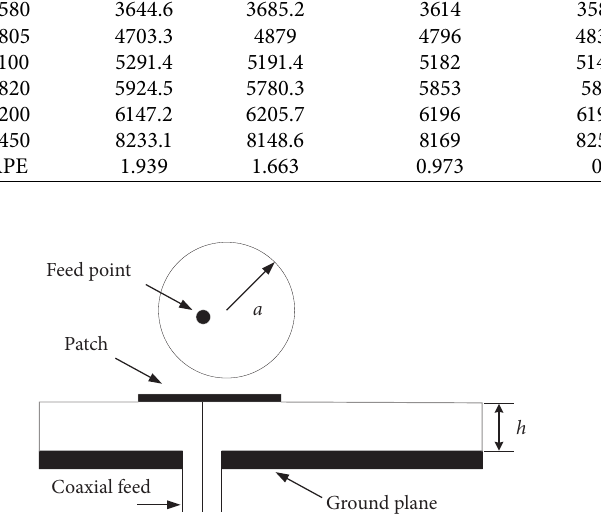
Figure 4: Schematic diagram of CMSA.